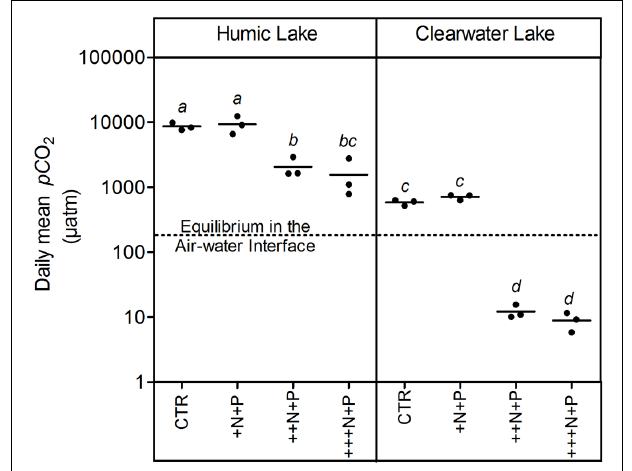
FIGURE 1 | Daily mean p CO 2 after different N additions for humic and clear waters, respectively from Lake Comprida and Lake Carapebus at the last day of the experiment. Each solid circle indicates one microcosm and the horizontal line the average.The four treatments are control (no additional nutrients) and three N levels ( + N, ++ N, and +++ N, respectively 40, 400, and 1600 μ M N – KNO 3 ) + P addition ( + P 20 μ M P – KH 2 PO 4 and K 2 HPO 4 ). No significant differences among treatments and lake waters were represented by equal lower case letters (Tukey–Kramer, p > 0.05).The dashed line represents the p CO 2 value at equilibrium with the overlying atmosphere (380 μ atm). Note that values are in log